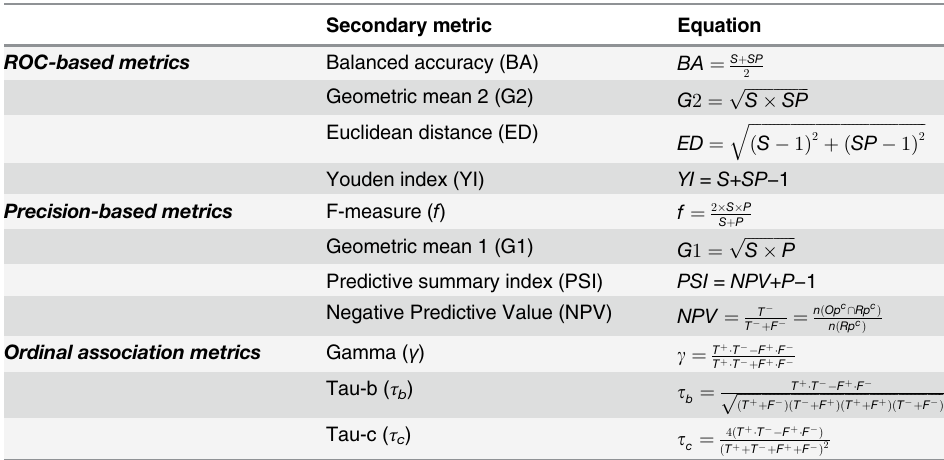
Table 3. Evaluation